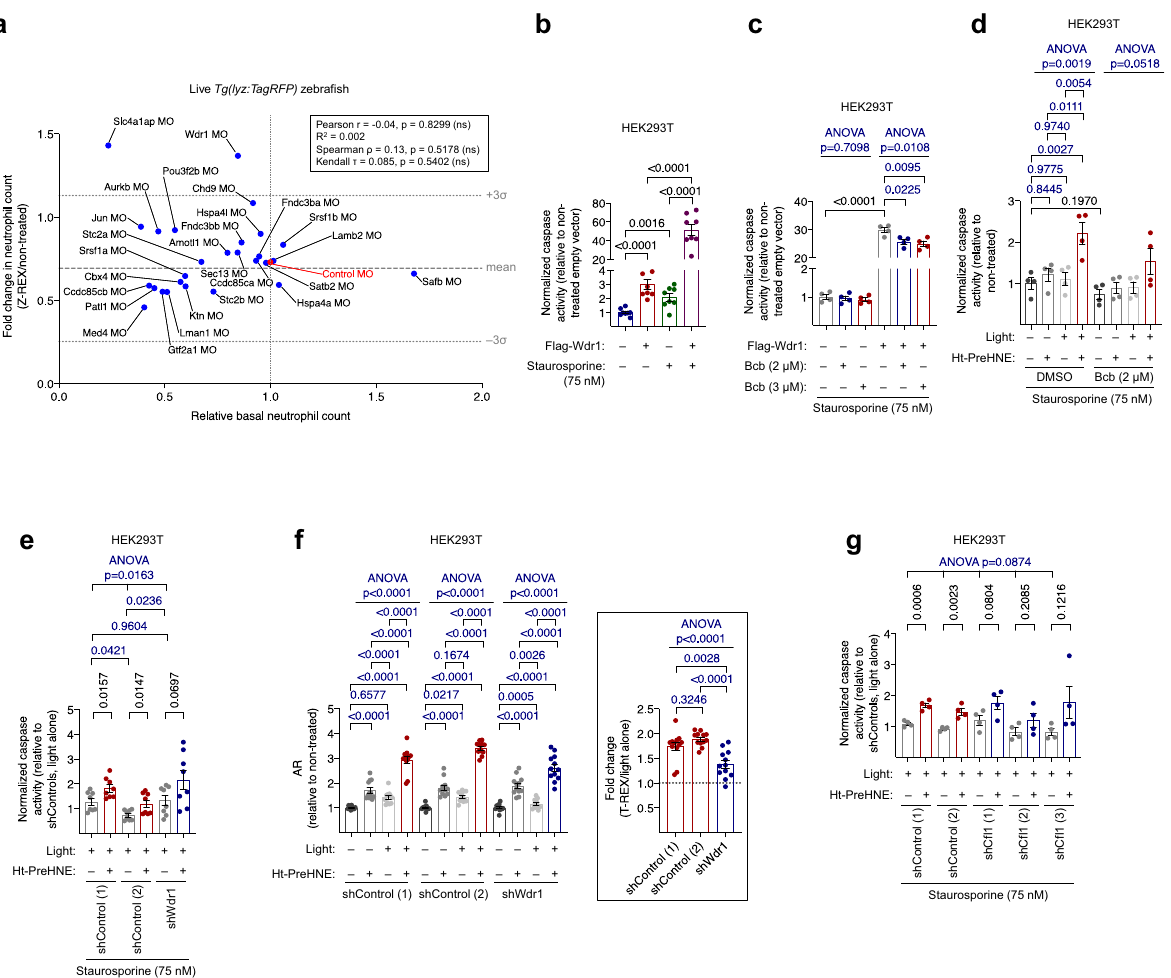
Fig. 3 Wdr1 links hydroxynonenylated Keap1 to Bax-dependent apoptosis. a Keap1-binding partners altered upon Keap1-speci fi c-hydroxynonenylation identi fi ed by SILAC proteomics (see Supplementary Table 2, Supplementary Data 2) were knocked down using MOs targeting indicated genes in Tg(lyz:TagRFP) , and Z-REX-mediated Keap1-hydroxynonenylation was performed in these knockdown backgrounds. X -axis: effect of the knockdown alone; Y -axis: the fold change in neutrophil count following Z-REX-mediated Keap1-hydroxynonenylation. These effects were not correlated. See Supplementary Fig. 9a, b. b HEK293T transfected with either empty vector or Flag-Wdr1 were treated with staurosporine for 18 h and Caspase-3 activity was measured. P values were calculated with Student ’ s t -test. c HEK293T transfected with either empty vector or Flag-Wdr1 were treated with staurosporine and/or Bcb for 18 h and Caspase-3 activity was measured. See Supplementary Fig. 11e, f. P values in black were calculated with Student ’ s t -test; P values in blue were calculated with ANOVA and Dunnett ’ s multiple comparisons test. d HEK293T subjected to T-REX-mediated Keap1-hydroxynonenylation and